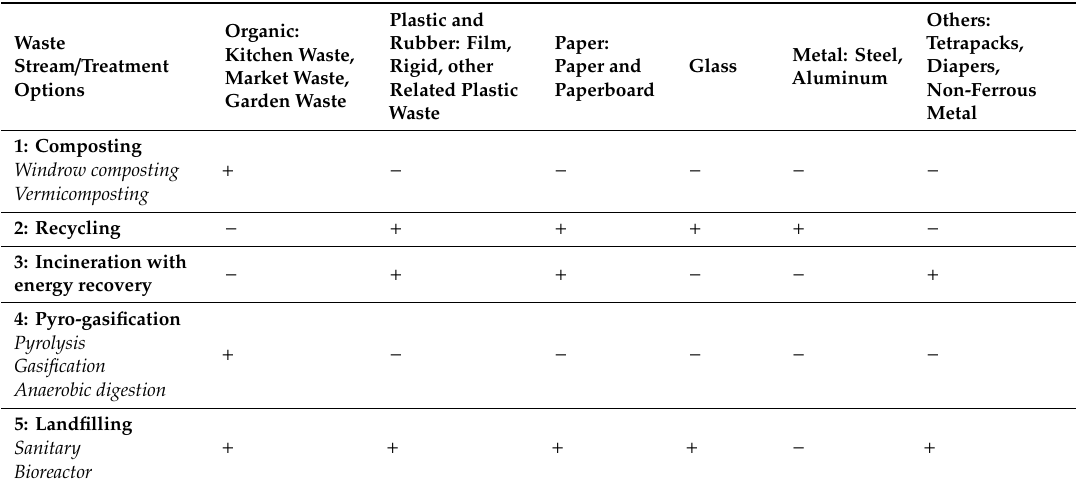
Table 1. Waste streams and potential treatment / management